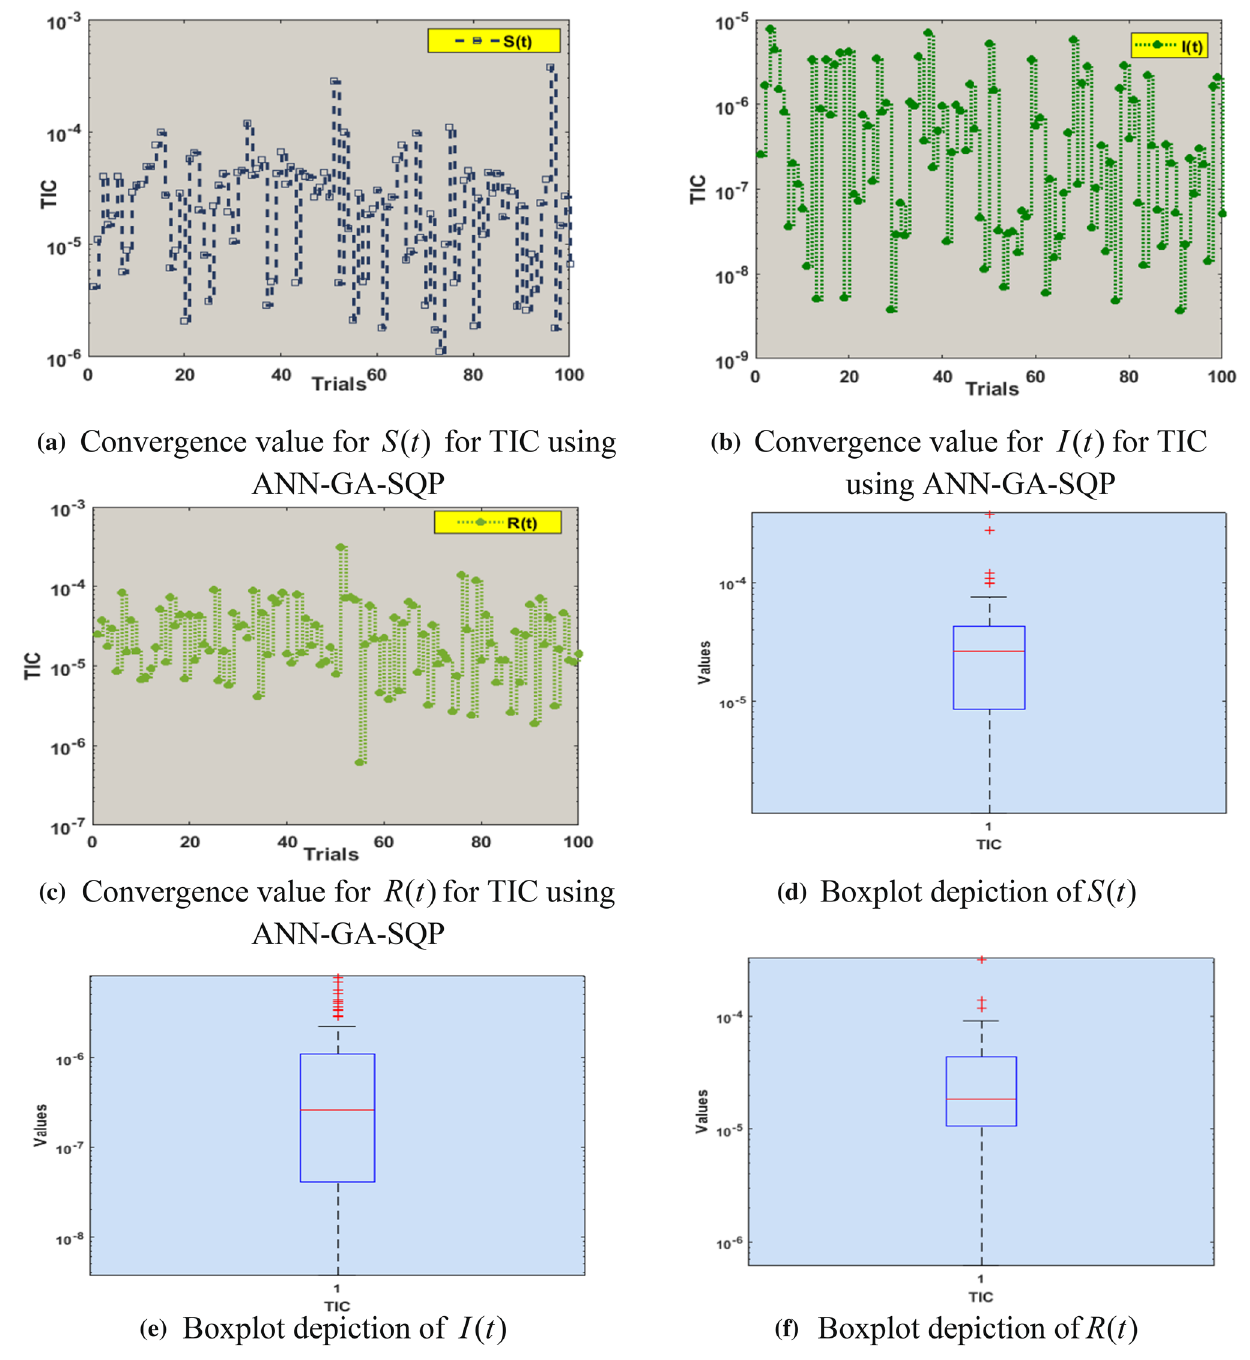
Fig. 4 Performance analysis of TIC for S ( t ), I ( t ) , R ( t ) with boxplots including 5 neurons using ANN-GA-SQP for COVID-19 SIR